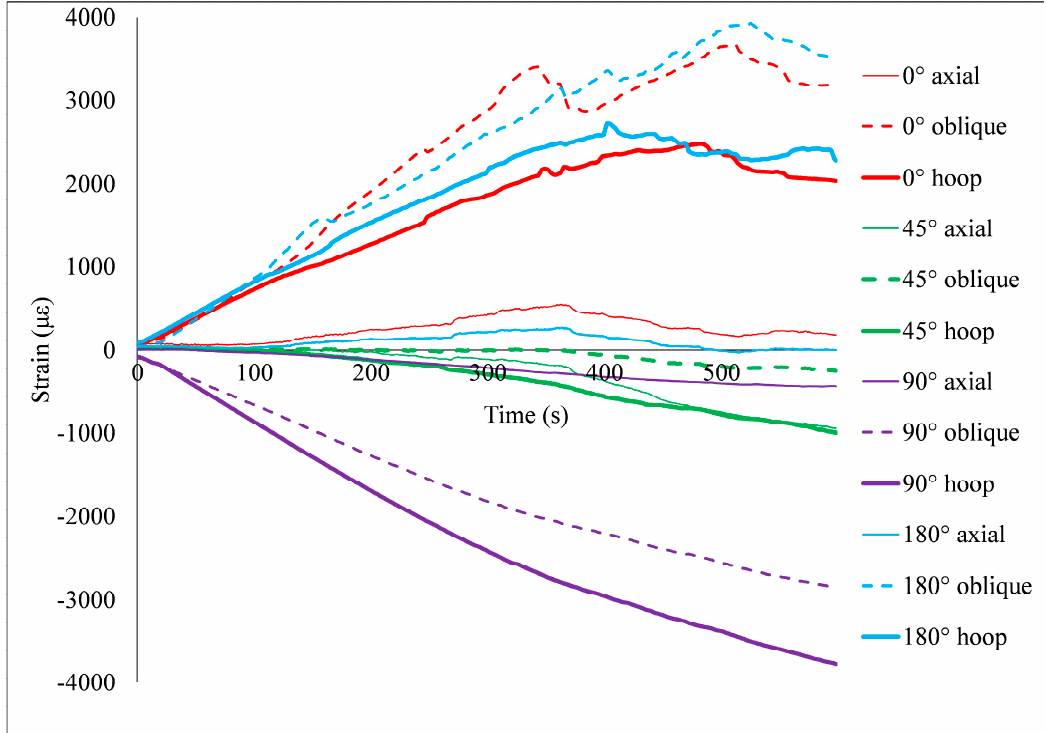
Figure 10. A typical strain-time curve for the outer stiffened type of DN400.